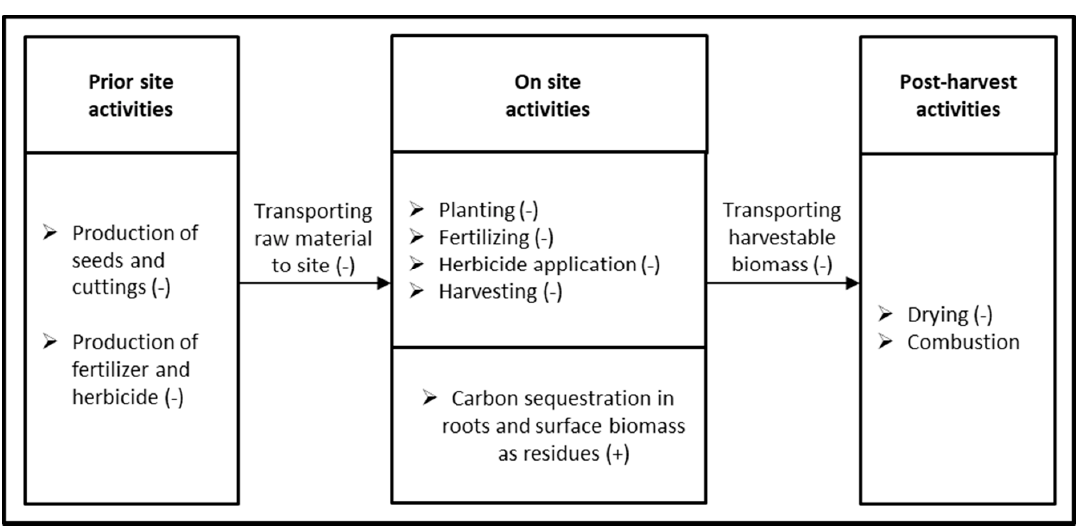
Figure 2. Carbon flow in processes included in the bioenergy system.